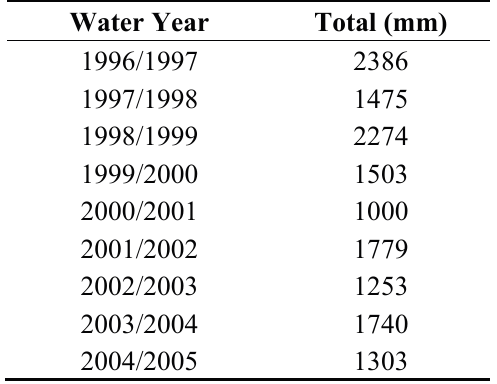
Table 4. Annual total precipitation by water year from 1996 to